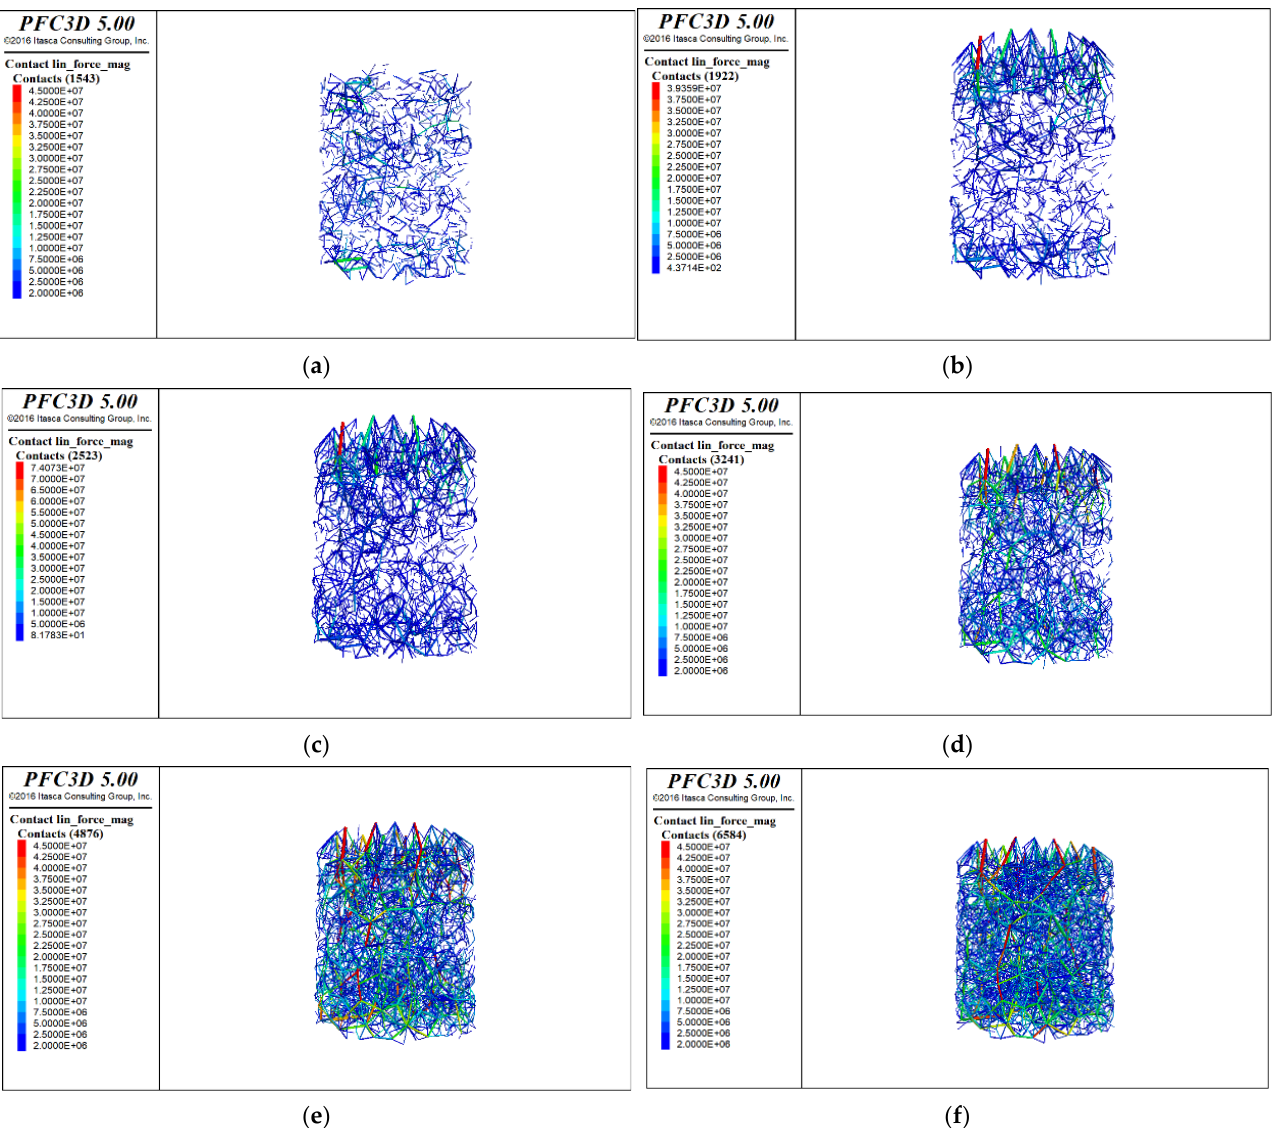
Figure 9. Skeleton particle force chain diagrams. ( a ) Force chain before vibration; ( b ) force chain after 10 s vibration; ( c ) force chain after 20 s vibration; ( d ) force chain after 30 s vibration; ( e ) force chain after 60 s vibration; and ( f ) force chain post vibration. In the figure, E is abbreviation for exponent, for example, the number 4.5E7 stands for 4.5 × 10 7